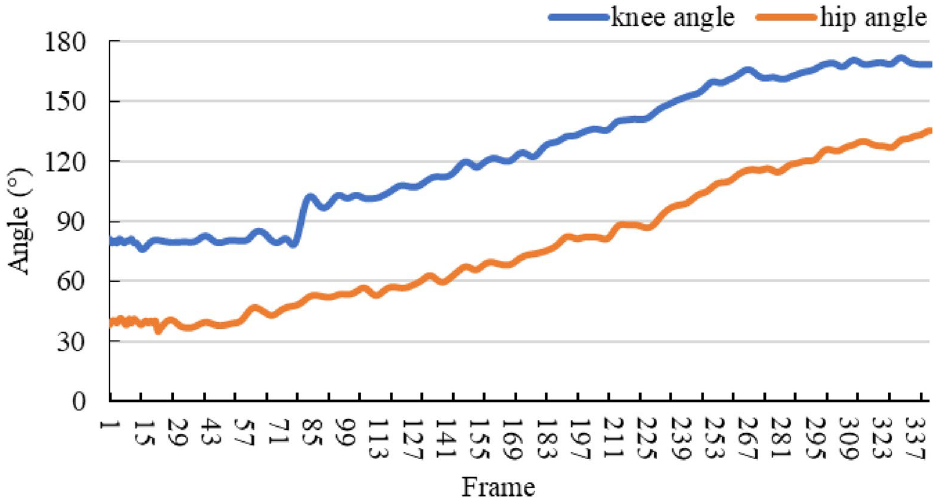
Figure 13. Changes in hip/knee angle versus frame